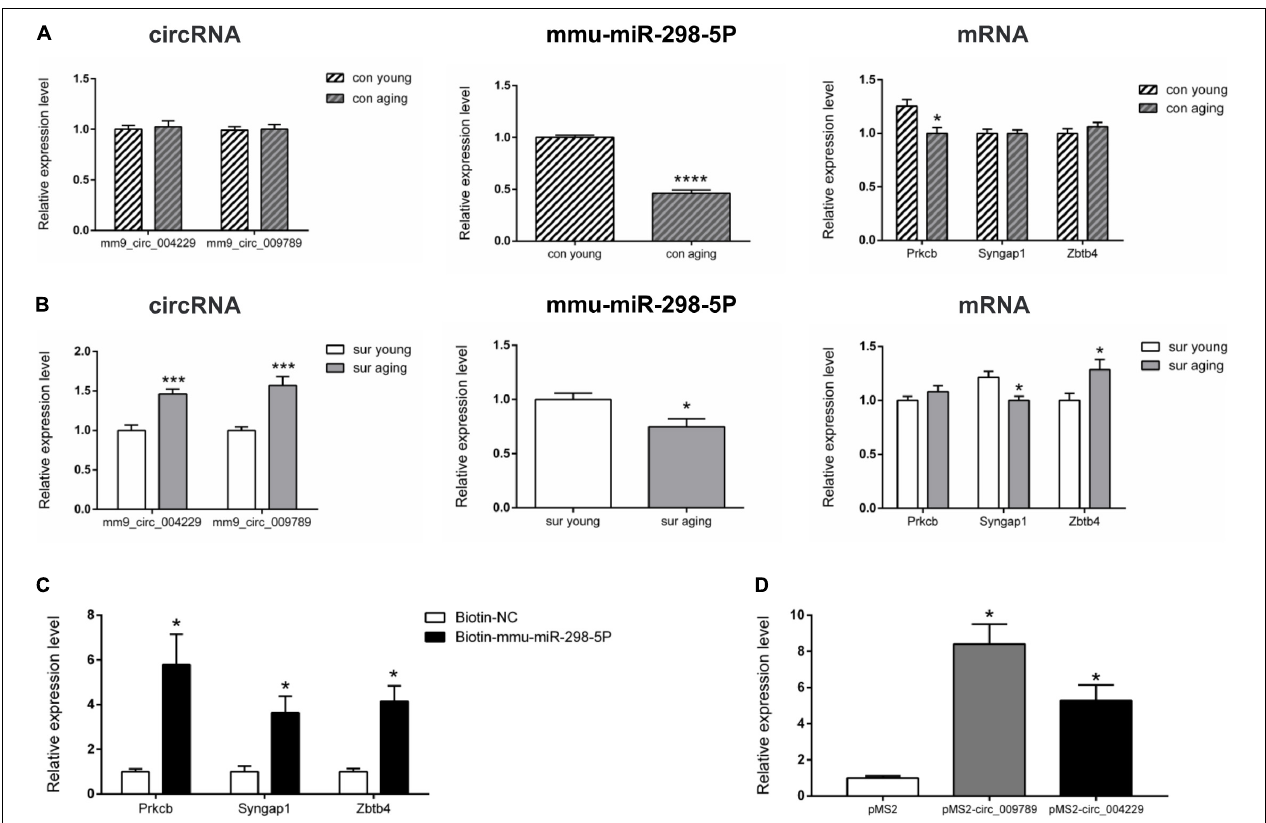
FIGURE 4 | Real-time qPCR validation and RNA pull down of circRNA-associated-ceRNA networks. (A,B) Real-time qPCR to analysis the expression of mm9_circ_004229, mm9_circ_009789, mmu-miR-298-5P, Prkcb, Syngap1 and Zbtb4 in young and aging mice under control and anesthesia/surgery conditions ( n = 6). (C) RNA pull-down assay to analysis mmu-miR-298-5P targets genes Prkcb, Syngap1 and Zbtb4 in Neuro-2A cell. (D) RNA pull-down assay to analysis mm9_circ_004229/mm9_circ_009789 associated mmu-miR-298-5P in Neuro-2A cell. * p < 0.05, *** p < 0.001, **** p < 0.0001. All data are presented as mean ±